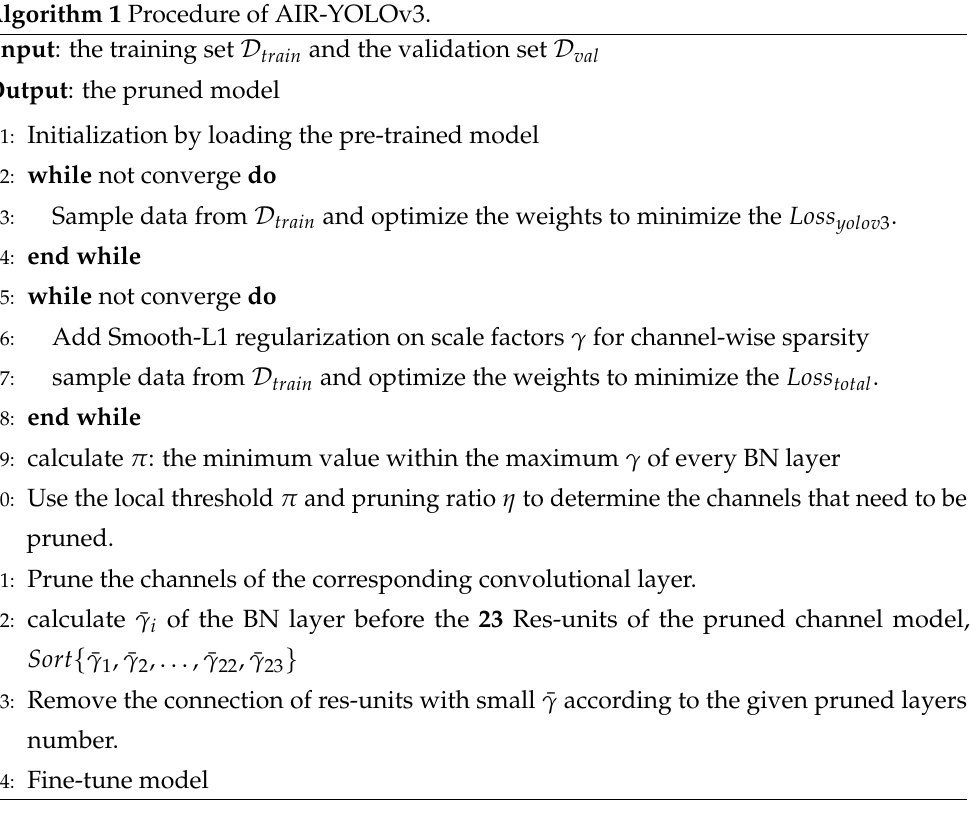
Algorithm 1 Procedure of